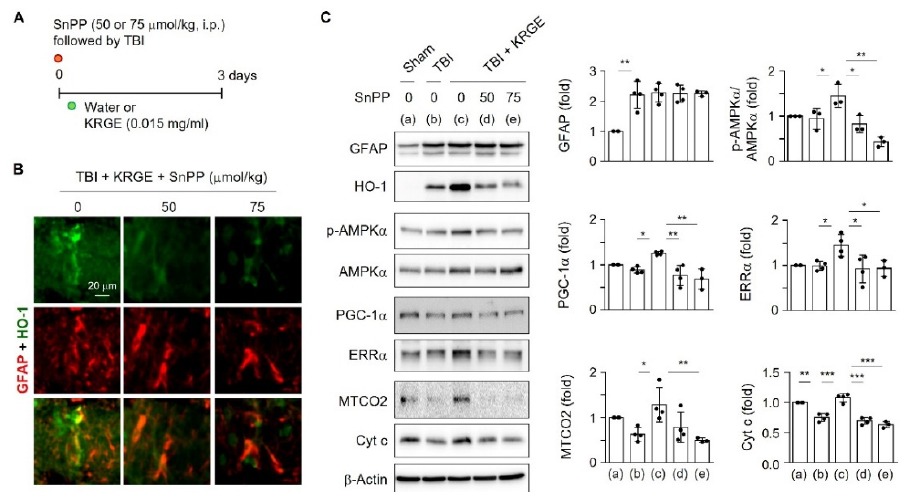
Figure 6. HO inhibition suppressed mitochondria-regulating proteins. ( A ) Schematic representation of SnPP, TBI, and KRGE conditions. ( B ) Representative image of HO-1 (green) and GFAP (red) co-expression in a mouse brain subjected to TBI, followed by KRGE treatment with or without SnPP ( n = 3 per group). Scale bar = 20 μ m. ( C ) The brain sections (approximately bregma − 1 to − 2) obtained after TBI followed by KRGE treatment with or without SnPP were detected with the indicated antibodies and assessed by Western blotting ( n = 3 or 4 per group). * p < 0.05; ** p < 0.01; *** p < 0.001.